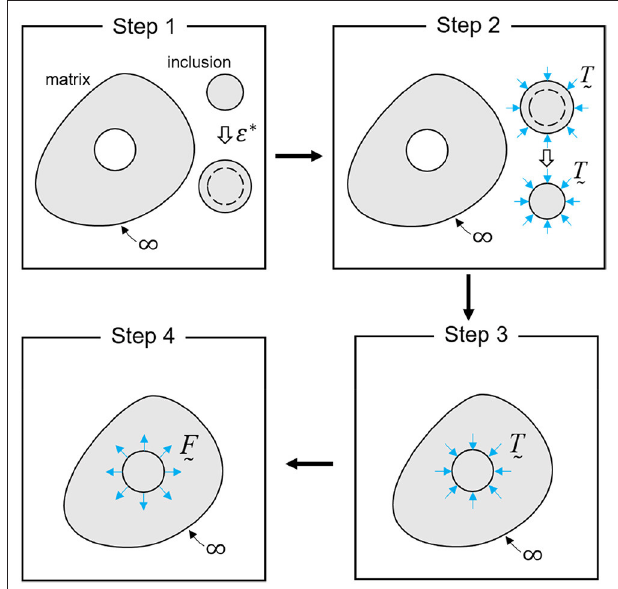
FIGURE 1 | Schematic of the single inclusion problem in